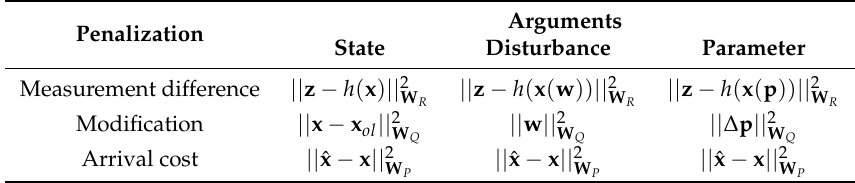
Table 2. Moving horizon estimation (MHE) cost function